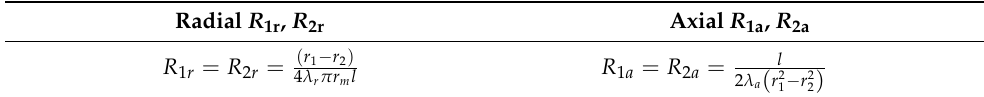
Table 2. Thermal resistance definition of “+”